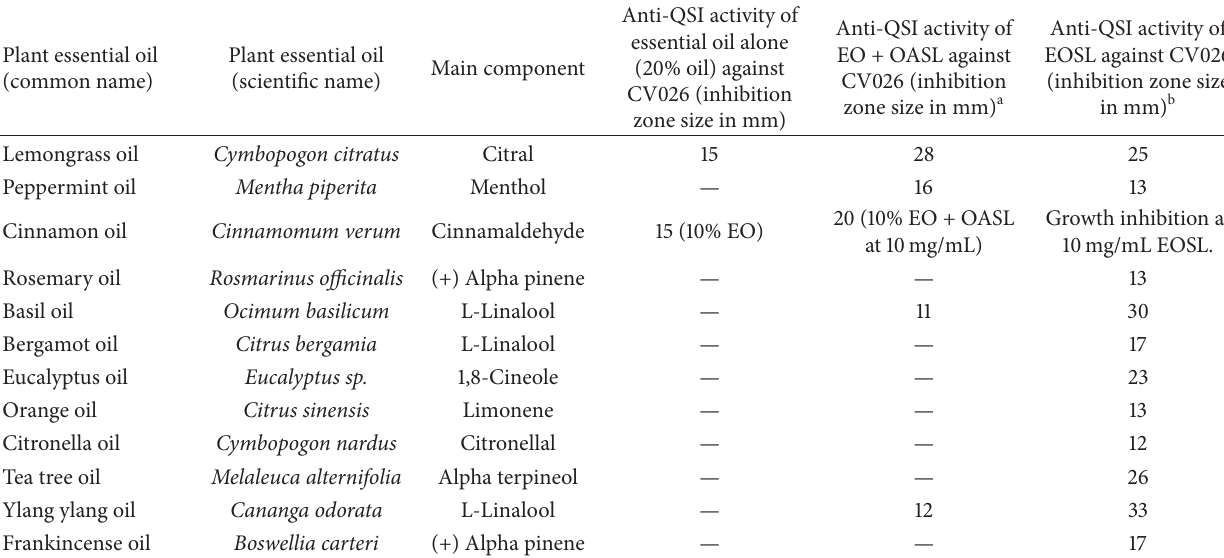
Table 1: Tabulated data showing quorum sensing inhibitory (QSI) activity of essential oils used in this study, alone and in combination with 10mg/mL of OASL. Also QSI activity of all synthesized EOSLs.